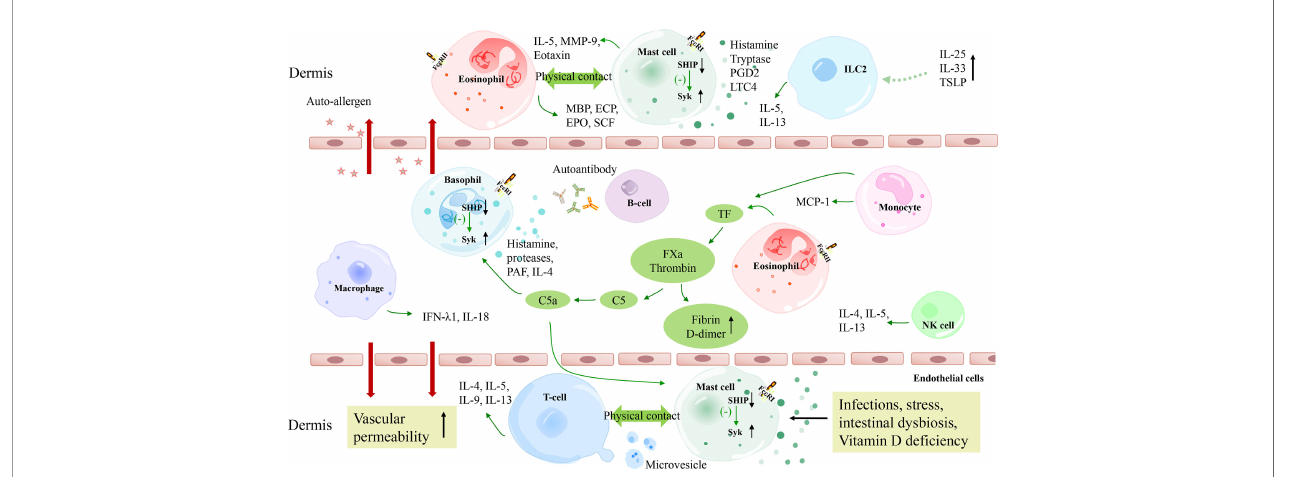
FIGURE 1 | A schematic model of the pathogenesis of CSU. The extrinsic coagulation pathway is activated by tissue factors derived from eosinophils and monocytes, which contributes to the degranulation of mast cells and basophils. Autoimmunity, infections, stress, intestinal dysbiosis, and Vitamin D de fi ciency also lead to mast cell degranulation via different molecular pathways. TSLP combined with IL-25 and IL-33 are suggested to be activating factors of ILC2s, which release IL-5 and IL-13 to promote mast cell degranulation. T cells and eosinophils perform complex bidirectional crosstalk with mast cells. Besides, macrophages and NK cells may also play a role in CSU pathogenesis. C5a, complement 5a; FXa, activated factor X; TF, tissue factor; Fc e RI, high-af fi nity IgE receptor; Syk, spleen tyrosine kinase; SHIP, Src homology 2-containing inositol 5 ’ phosphatase; PGD2, prostaglandin D2; LTC4, Leukotriene C4; MMP-9, matrix metalloproteinase-9; TSLP, thymic stromal lymphopoietin; MCP-1, monocyte chemoattractant protein 1; ECP, eosinophil cationic protein; EPO, eosinophil peroxidase; MBP, major basic protein; SCF, stem cell